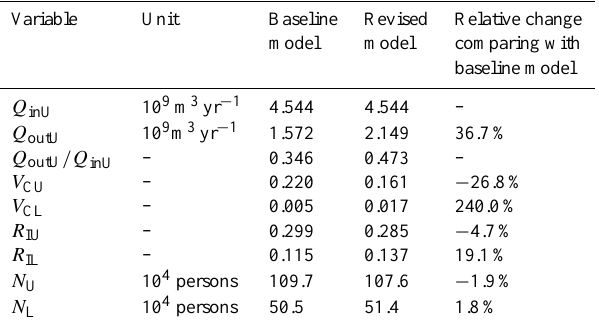
Table 3. Mean values of state variables during the last 60 years of system evolution. Variable Unit Baseline Revised Relative change model model comparing with baseline